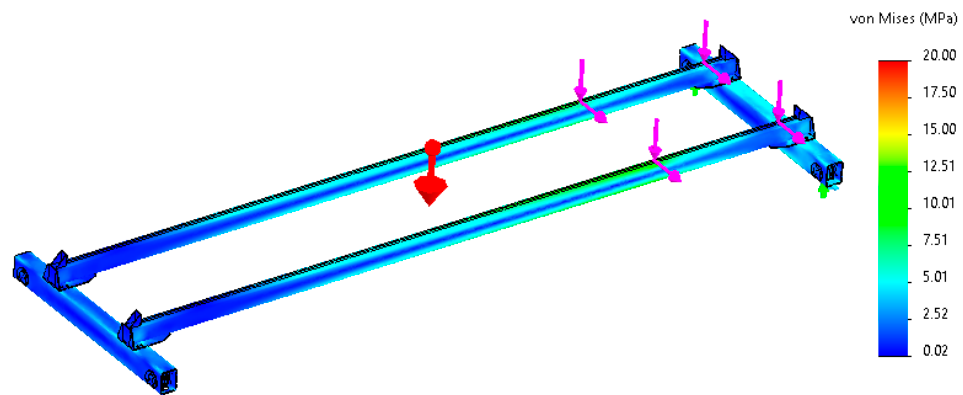
Figure 4. Crane bridge simulation model.